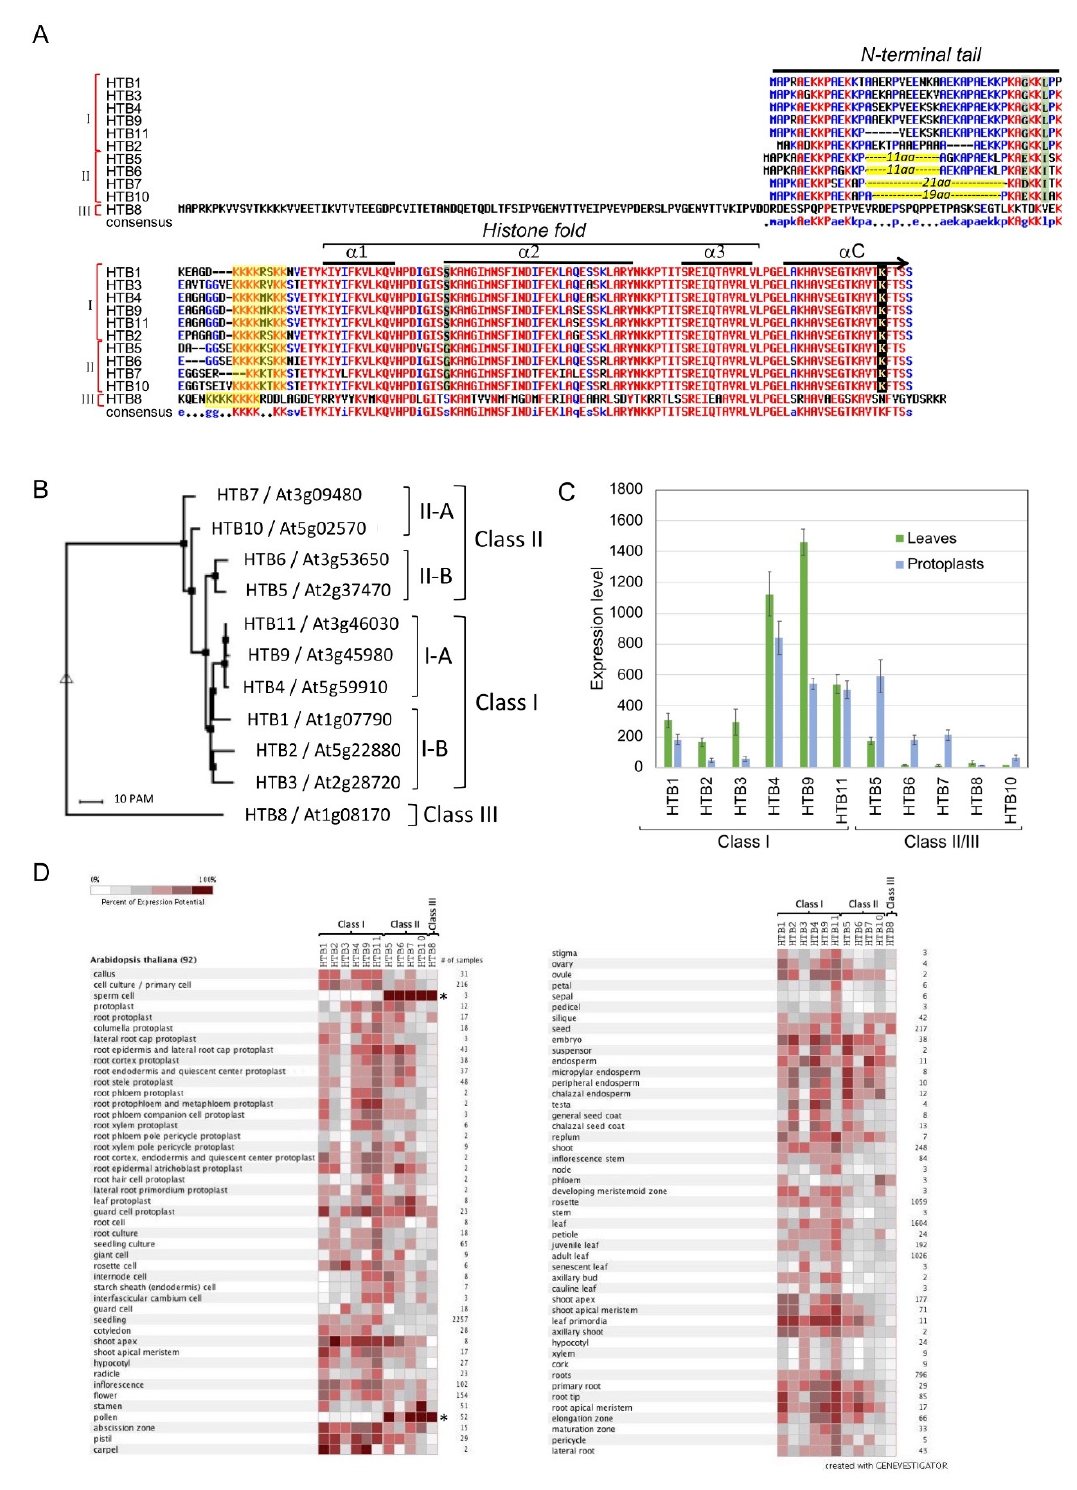
Figure 1. HTB variants in Arabidopsis thaliana (HTBs). ( A ) Amino acid sequence alignment of HTB variants in Arabidopsis thaliana using Multalin interface page [32]. Variation in amino acids between classes I, II, and III are highlighted green, and the C terminus lysine (K) residue undergoing monoubiquitination is highlighted and marked by an arrow. The yellow box indicates a potential nucleolar localization / retention signal, which is also known as the histone H2B repression domain (HBR). The N-terminal tail and the histone fold region with alpha ( α ) helices are marked. α C indicates the C-terminal α helix. The position of the 11 and 19 / 21 aa motifs deleted in class II are highlighted yellow. ( B ) A phylogenetic